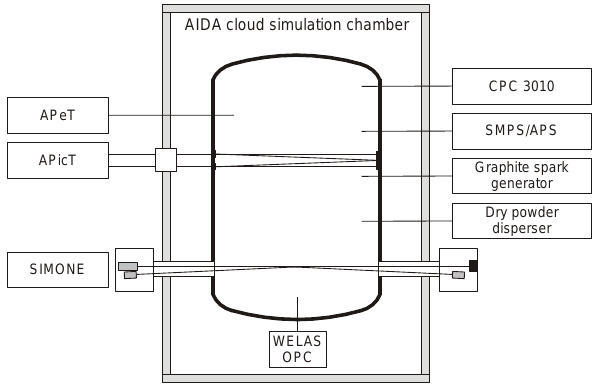
Fig. 1. Schematic drawing of the AIDA cloud chamber with in- strumentation for humidity measurements (APicT and APeT), ice Figure 1. Schematic drawing of the AIDA cloud chamber with instrumentation for humidity 3 particle characterization (SIMONE and WELAS optical particle measurements (APicT and APeT), ice particle characterization (SIMONE and WELAS 4 counter), aerosol generation (graphite spark generator and dry- powder disperser), and aerosol characterization (CPC 3010, SMPS, optical particle counter), aerosol generation (graphite spark generator and dry powder 5 and APS). The gray frame illustrates the thermostated insulating disperser), and aerosol characterization (CPC 3010, SMPS, and APS). The gray frame 6 housing surrounding the AIDA illustrates the thermostated insulating housing surrounding the AIDA chamber 7